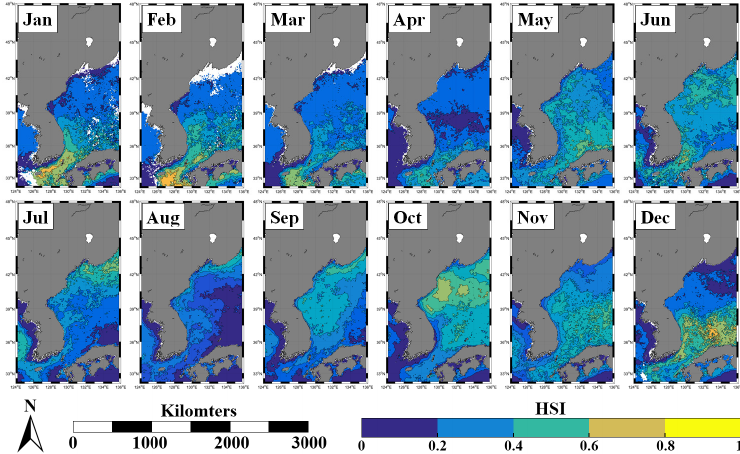
Figure 6. Climatological monthly distribution of the HSI around South Korea from 2002 to 2016.